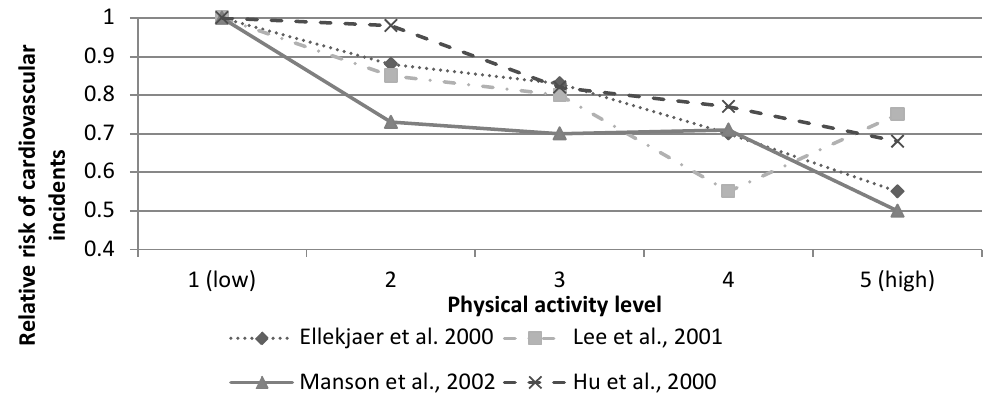
Figure 1. Associations between the risk of cardiovascular incidents and physical Figure 1: Associations between physical activity and reduced risk of incident coronary heart disease and coronary events activity